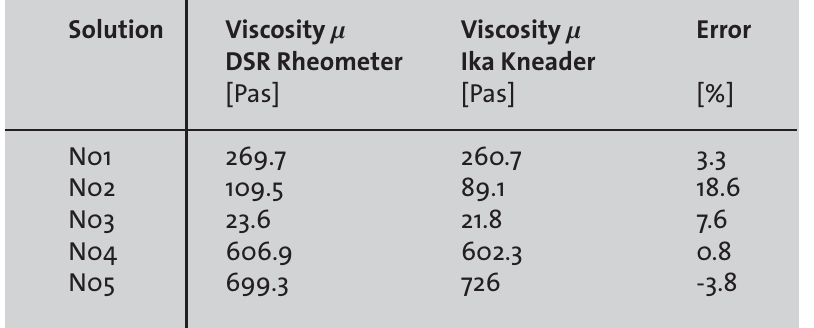
Table 3 (left): Error analysis for rheometer and kneader data. Figure 9 (right): Comparison of rheometer and kneader data for a) NN01, b) NN02, c) NN03, and d) NN04 with a =